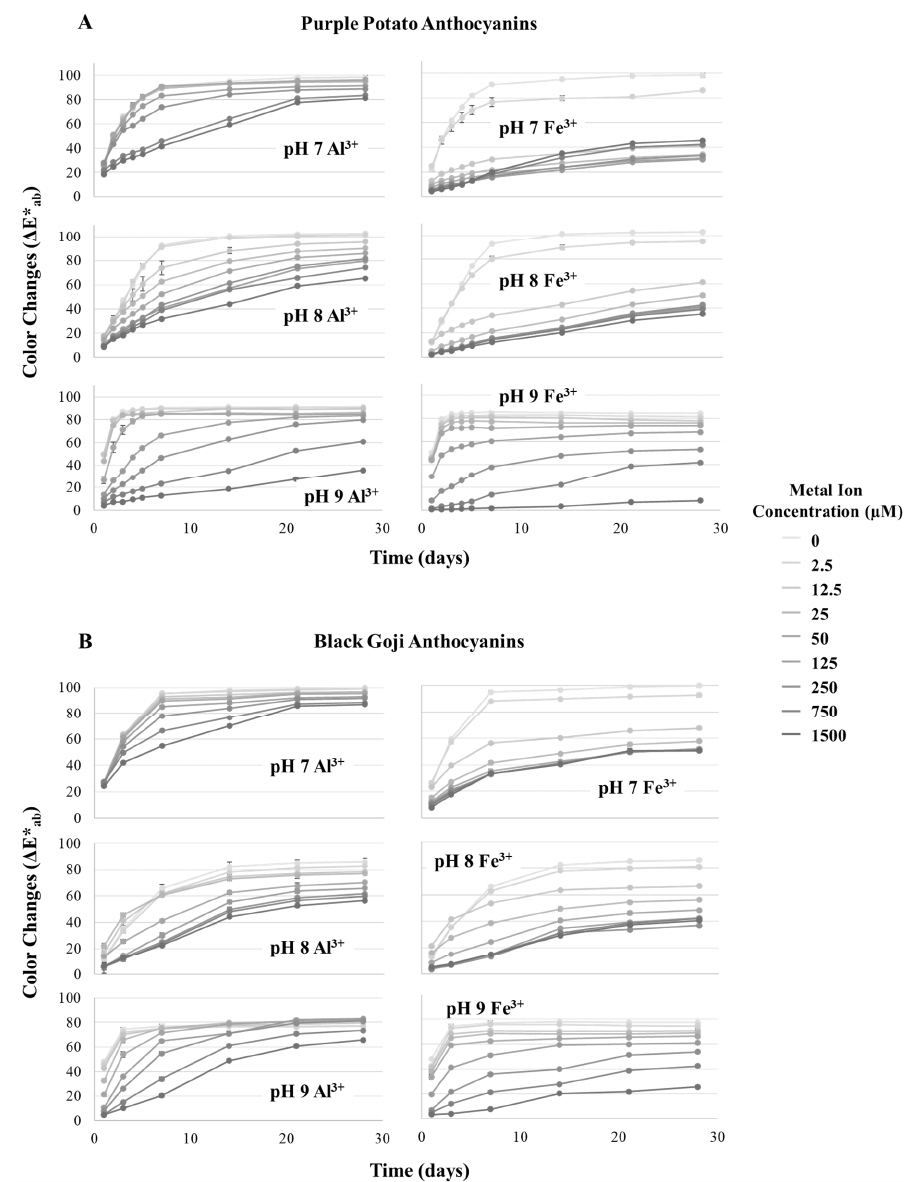
Figure 5. Color changes ( ∆ E* ab ) of purple potato ( A ) and black goji ( B ) anthocyanin metal chelates at pH 7–9 over 28 days. Samples were stored under refrigerated conditions in the dark.